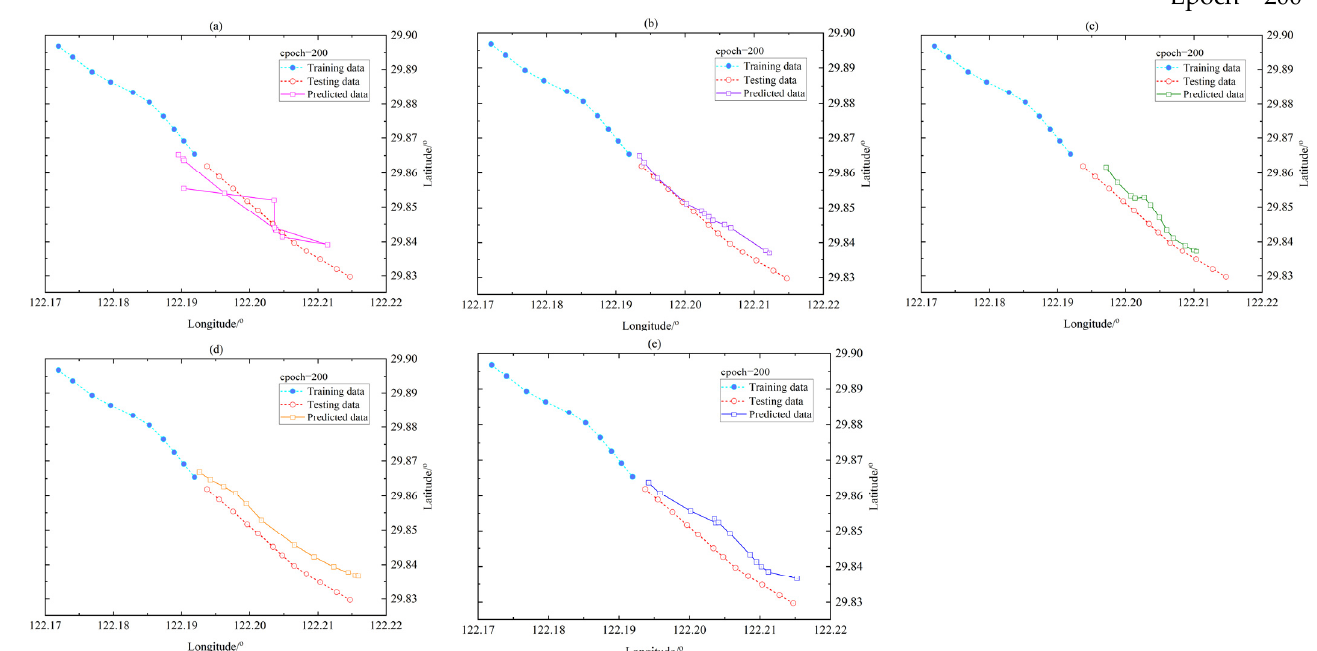
Figure 11. The comparison of the performance after learning 200 epochs of di ff erent methods: ( a